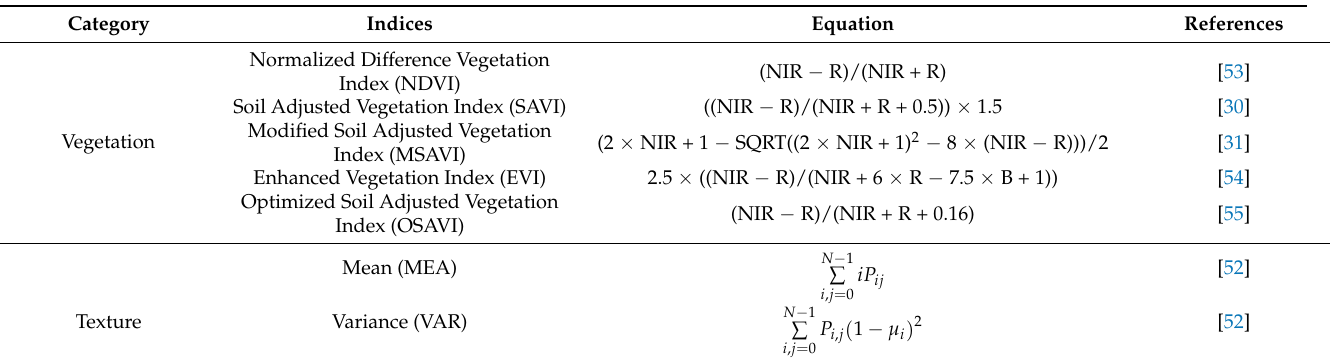
Table 2. The vegetation and texture indices for estimation of fine fuel biomass using the random forest